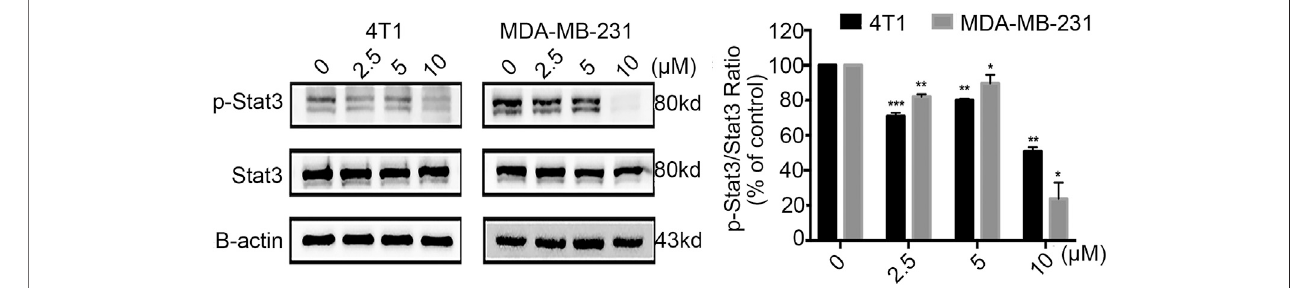
FIGURE 6 | Statmp-151 inhibited phosphorylation of Stat3. The cells treated with Statmp-151 for 24 h were used, and the expression levels of Stat3 and p-Stat3 Tyr705 were measured by western blotting and the protein expression was quanti fi ed.